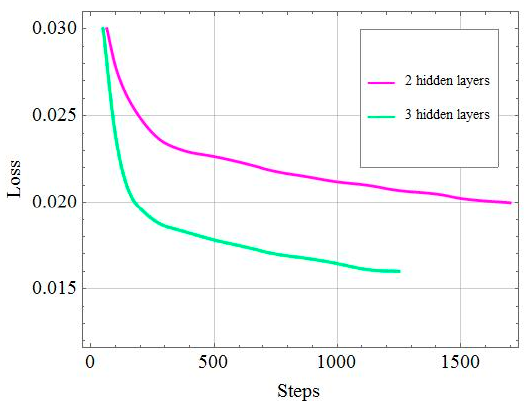
Figure 5. Loss over time on the training set for different depths of the deep neural network (DNN).